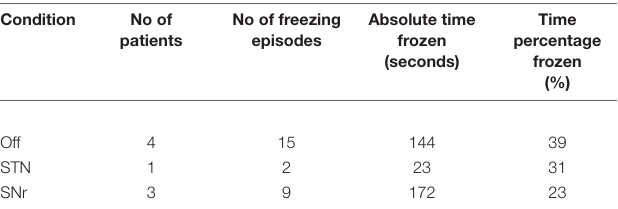
TABLE 2 | Freezing characteristics in different therapeutic conditions. Condition No of No of freezing Absolute time patients episodes frozen